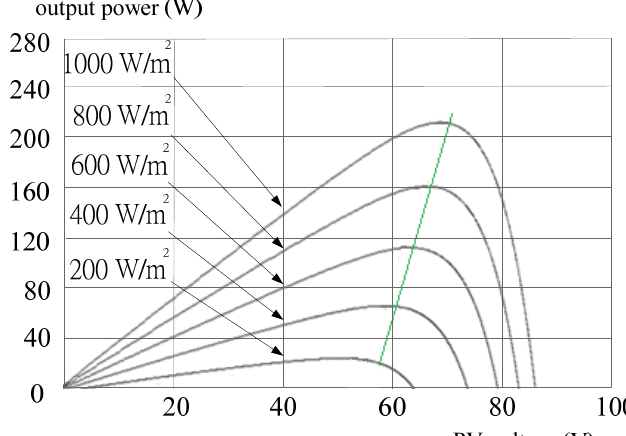
Figure 11. The MPPT trajectory by the DLAA under fixed